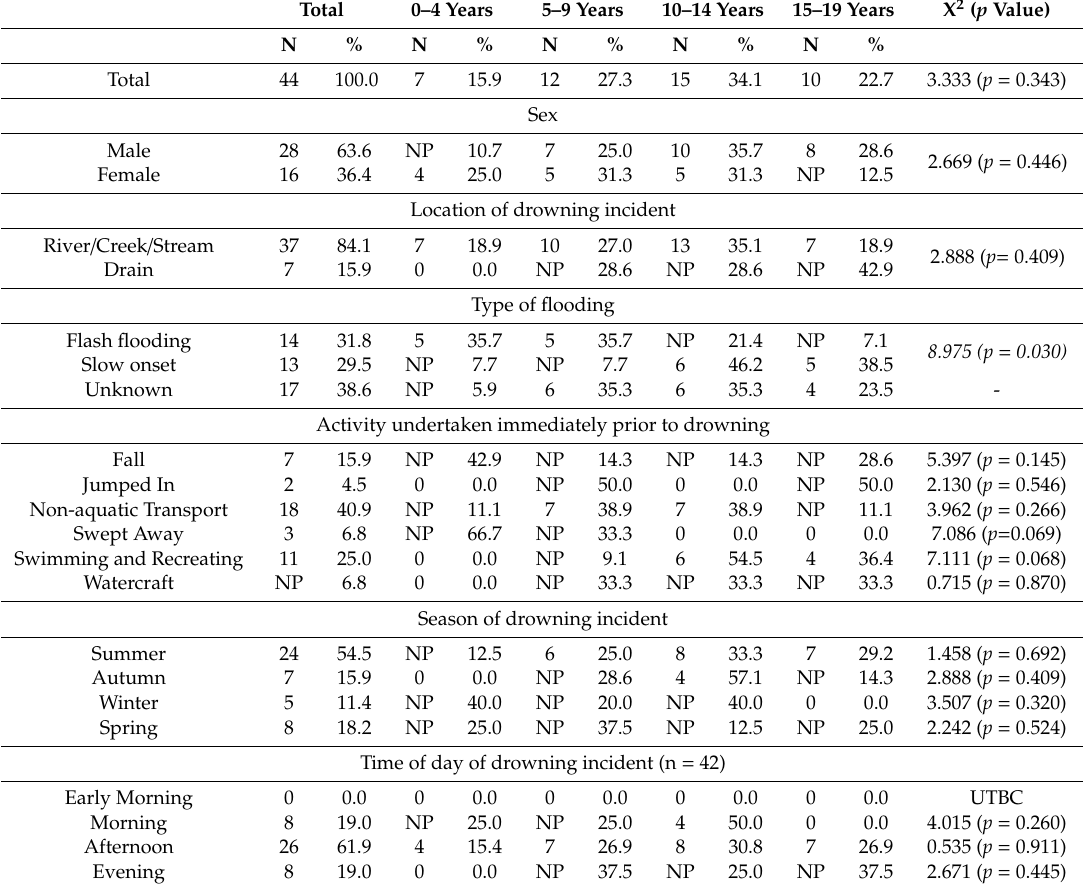
Table 2. Demographics and circumstances of child and adolescent unintentional flood-related